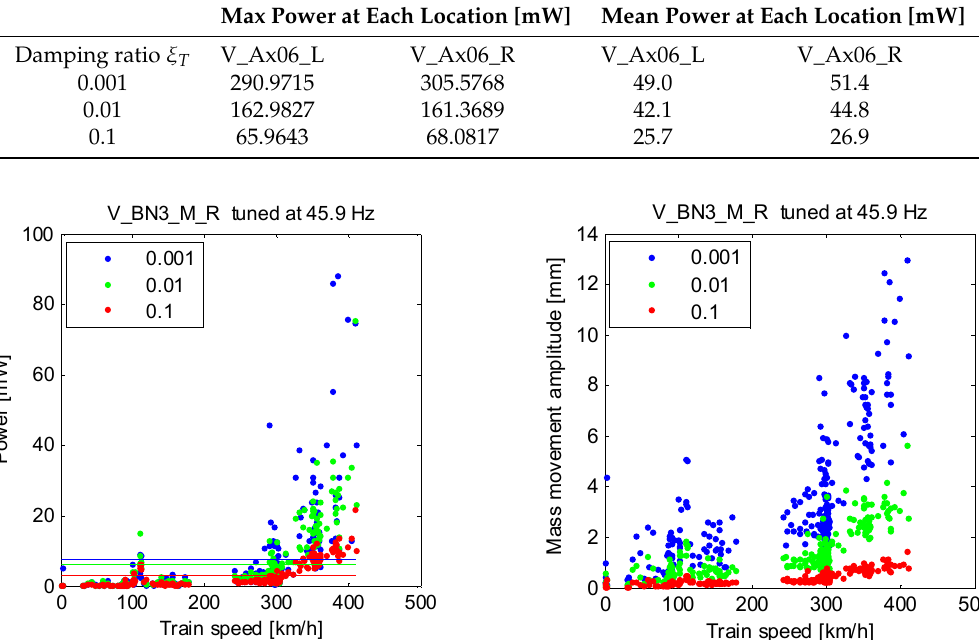
Figure 12. The relative vibration amplitudes of the harvester mass from the vertical vibration of the axles when the total damping ratio ξ T is 0.001, 0.01, or 0.1; the mass is 0.1 kg; and the natural frequency is 50.3 Hz (at the vertical direction of each left and right side of number 6 axle: V_Ax06_L and V_Ax06_R). Table 2. The max power estimates of vertical axle vibrations with 0.1 kg mass, 50.3 Hz natural frequency, and three di ff erent total damping ratios ξ T around 300 km / h and the mean power estimation.